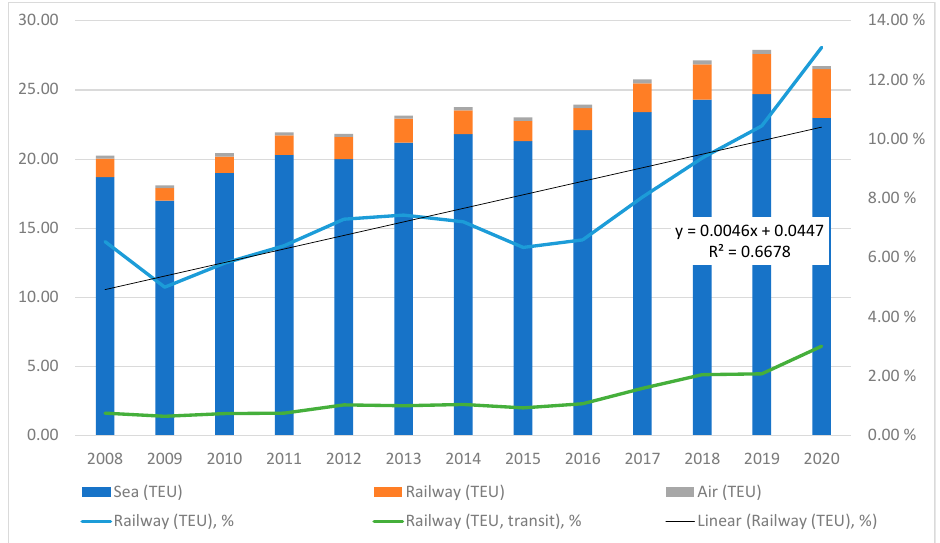
Figure 5. Container transportation volumes between Asia and Europe within three different transportation modes (air freight converted to TEU with the assumption of 10 tons per TEU container; million TEU). Denotation: Railway data based on Russian railway data [33–39]; air freight estimated with first three quarters of 2020 [15]; sea containers based on Unctad [7]